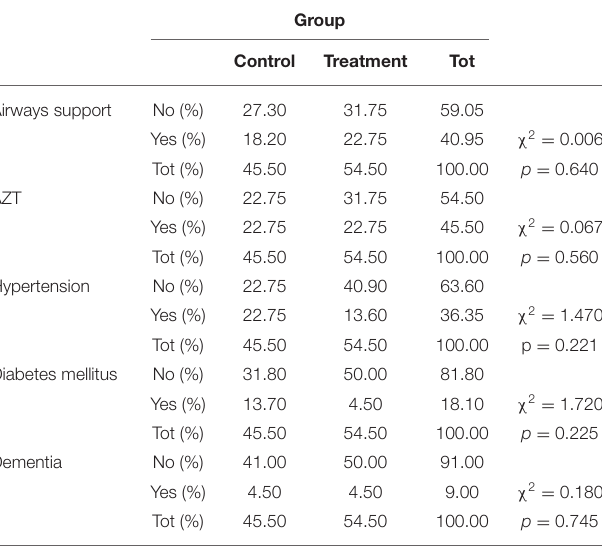
The data are shown as percentages. Among groups, the presence of difference in aspect ratio was analyzed with the Chi square test, statistical significance was attributed as p <